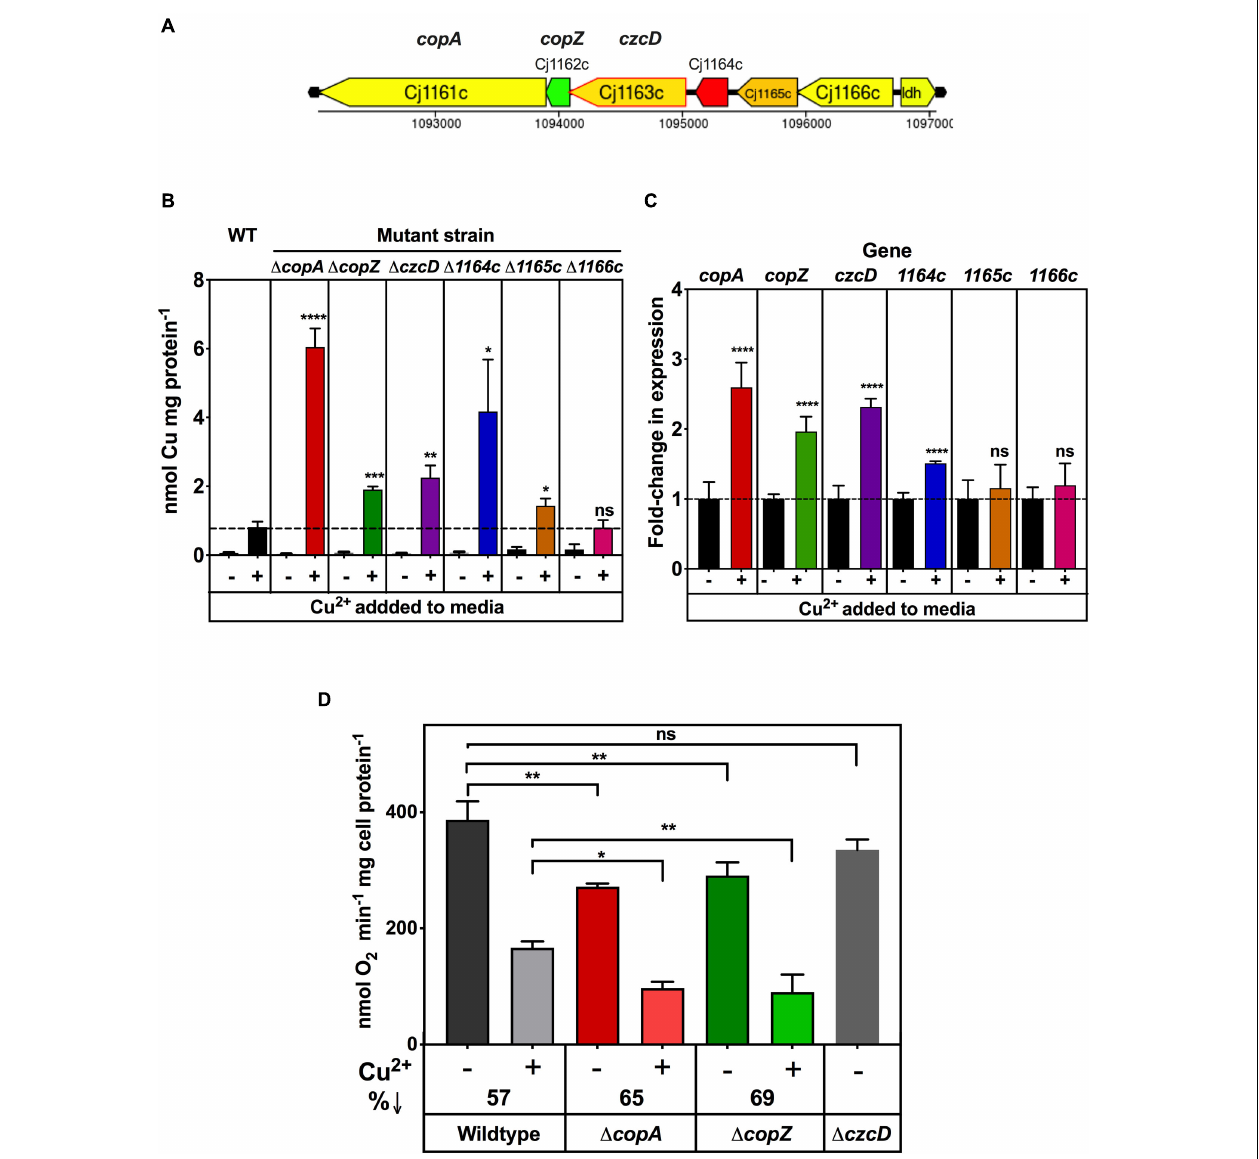
FIGURE 7 | Impairment of copper homeostasis negatively affects Cco activity. (A) Arrangement of genes encoding potential metal homeostasis proteins in C. jejuni . Genes are colour coded according GC content as in the legend to Figure 2 . (B) Intracellular Cu accumulation in wild type, (cid:49) copA , (cid:49) copZ , (cid:49) czcD , (cid:49) cj1164c , (cid:49) cj1165c , and (cid:49) cj1166c cells grown either in unsupplemented MEM α minimal medium or with 0.25 mM copper sulphate added. Intracellular Cu content at stationary phase was measured by ICP-MS and normalised to total cell protein concentration as measured by Lowry assay. The data are the means of independent triplicate cultures with error bars showing SD. One-way ANOVA was performed to determine the significance of the difference between wild-type plus copper and the corresponding mutants plus copper ( p > 0.05, ns; 0.05 > * p > 0.01; 0.01 > ** p > 0.001; 0.001 > *** p > 0.0001; 0.0001 > **** p ). (C) Effect of copper on gene expression, measured by qRT-PCR. C. jejuni wildtype cells were grown with or without 0.25 mM copper sulphate as in panel (B) . RNA was extracted (see “Materials and Methods”) and qRT-PCR performed using primers shown in Table 2 with the gyrA gene used as an internal control. The data are the means of independent triplicate cultures with error bars showing SD. For each gene, Students t -test was performed to determine the significance of the difference between expression measured without added copper (set to onefold in each case) and with added copper ( p > 0.05, ns; 0.0001 > **** p ). (D) Cytochrome c oxidase activity in copper homeostasis mutants. C. jejuni wildtype, (cid:49) copA , (cid:49) copZc , and (cid:49) czcD cells were grown in 5 ml MEM α minimal media in six-well plates, three wells with 0.25 mM copper sulphate and the other three wells without. Cytochrome c oxidase activity was measured by ascorbate/TMPD driven oxygen uptake normalised to total cell protein. The data are the average of independent triplicate cultures with error bars showing SD. One-way ANOVA was performed to determine the significance of the difference between wildtype and the mutants shown, either without or with added copper sulphate ( p > 0.05, ns; 0.05 > * p > 0.01; 0.01 > ** p > 0.001). The decrease in oxidase activity caused by growth with excess copper is indicated as% ↓